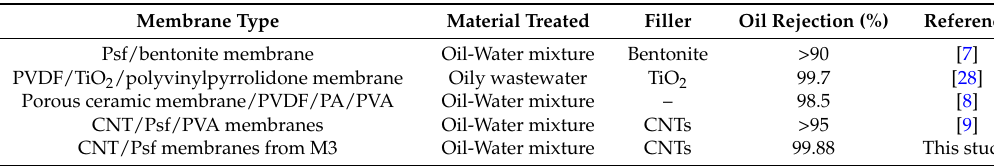
Table 4. Results compared with